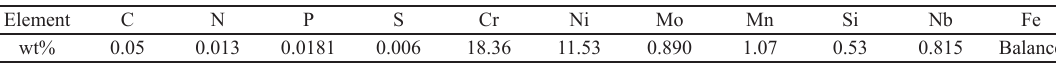
Table 1. Chemical composition of TP347H steel